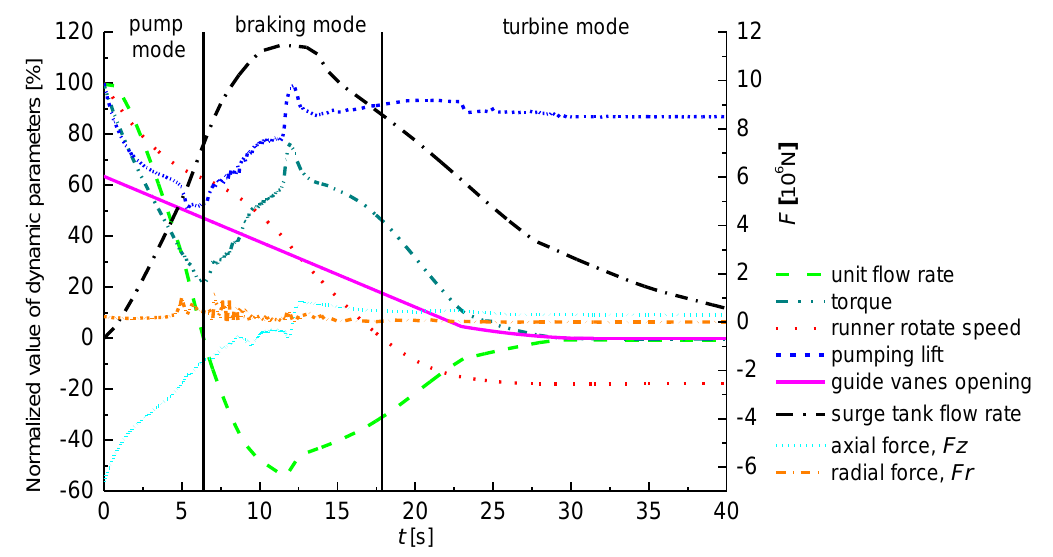
Figure 7. The left Y -axis is shared by normalized value of dynamic parameters variations with time; the right Y -axis is shared by axial and radial force on runner vs. time.